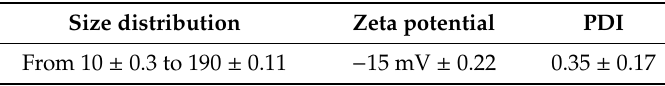
Table 1. Size, PDI, and Zeta potential of Cur /